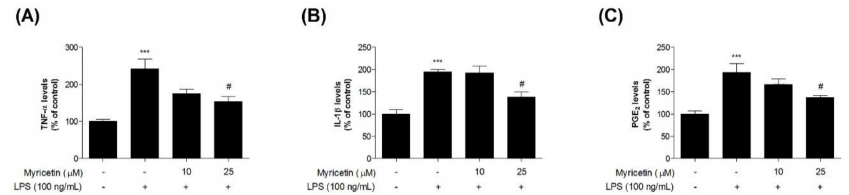
Figure 4. The effect of myricetin on LPS-induced TNF- α , IL-1 β , and PGE 2 levels in microglia BV2 cells. Cells were treated with myricetin for 1 h, and then stimulated with LPS for an additional 23 h. ( a ) TNF- α , ( b ) IL-1 β , and ( c ) PGE 2 levels were measured by ELISA kits. Values are means ± standard error of the mean. *** p < 0.001 compared to the control group, and # p < 0.05 compared to the LPS-alone group. LPS, lipopolysaccharide; TNF- α , tumor necrosis factor- α ; IL-1 β , interleukin-1 β ; PGE2, prostaglandin